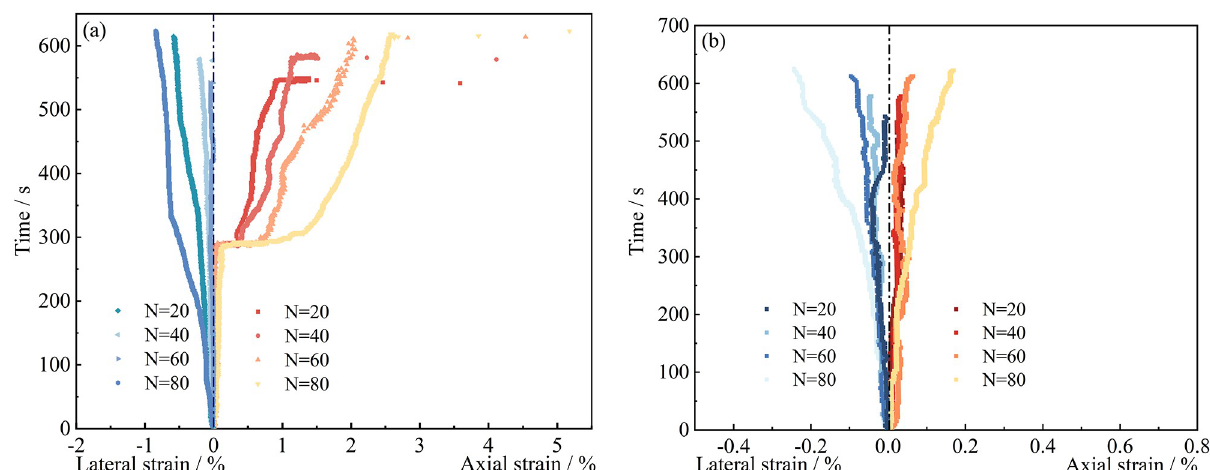
Fig 7. The variation of strain with time. (a) Strain in cracked area (b) Strain in non-cracked area.